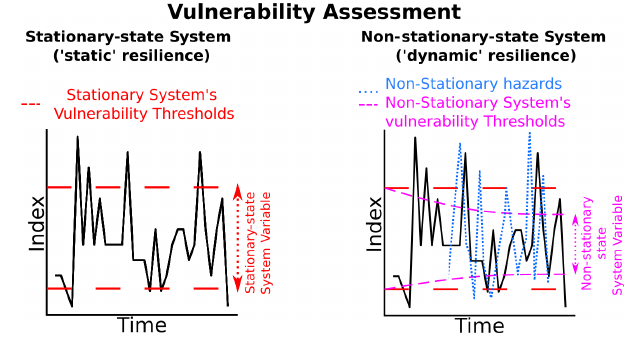
Figure 4. Graphical representation of static- and dynamic-state re- silience